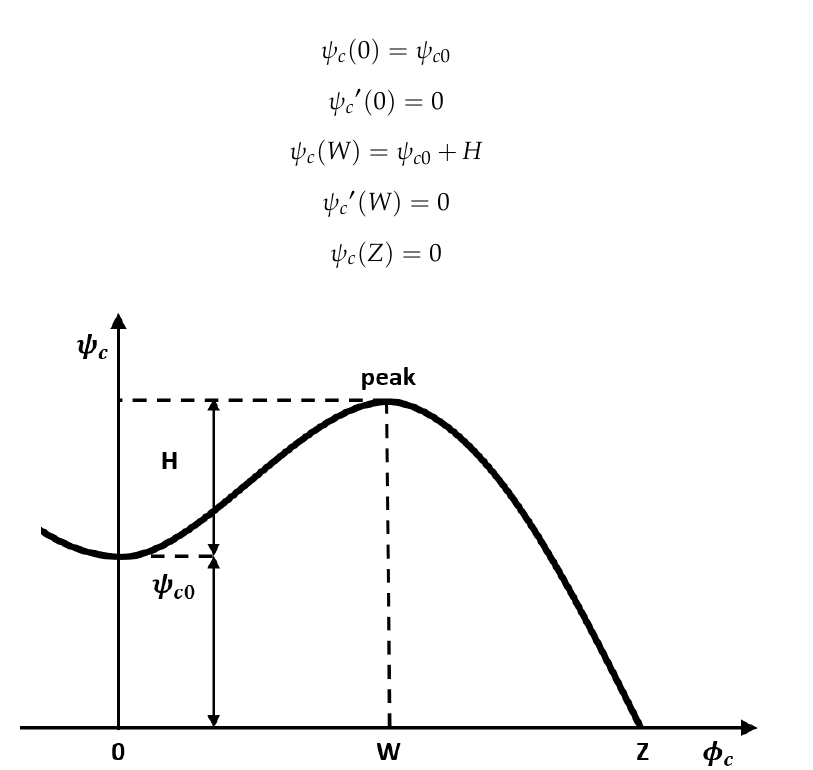
Energies 2020 , 13 , x FOR PEER REVIEW Figure 3. Fourth order polynomial compressor performance curve approximation. Figure 3. Fourth order polynomial compressor performance curve approximation.